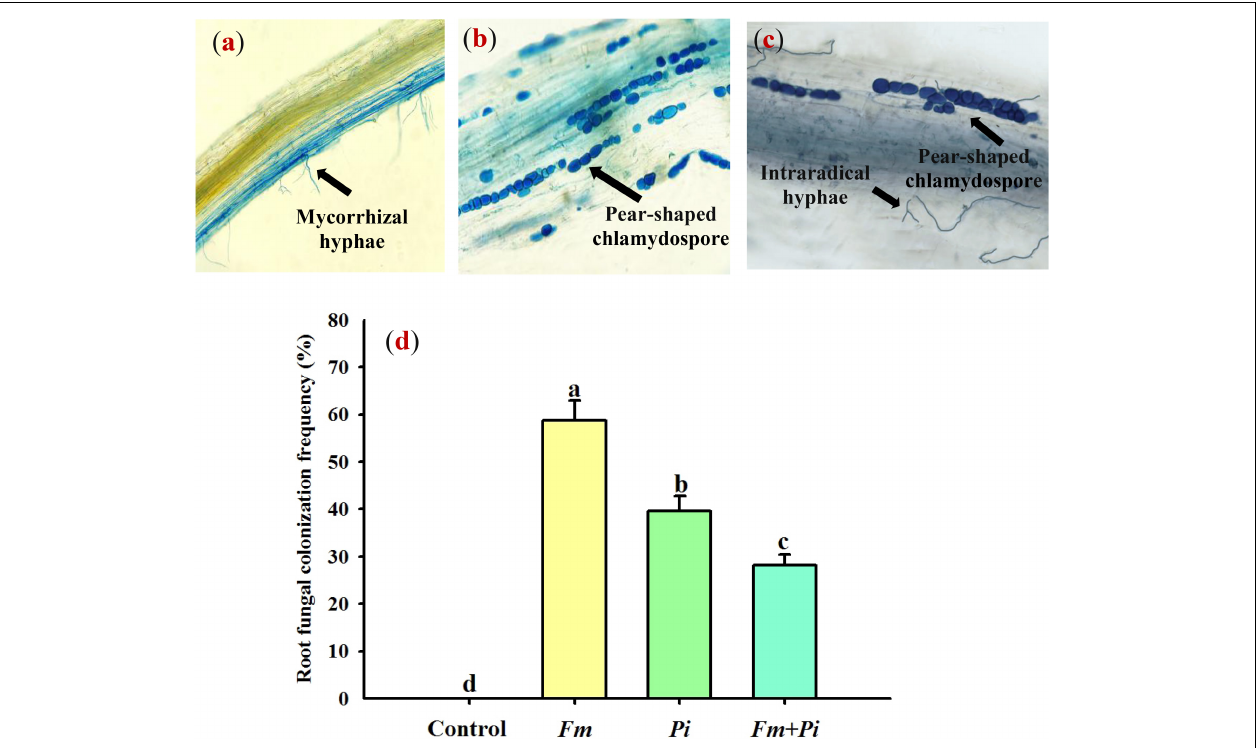
FIGURE 1 | Root fungal colonization of Polygonum cuspidatum Sieb. et Zucc by Funneliformis mosseae ( Fm ) and Piriformospora indica ( Pi ) single or in combination. (a) Fm -inoculated roots; (b) Pi -inoculated roots; (c) roots inoculated with Fm and Pi in combination ( Fm + Pi ); (d) changes in root fungal colonization frequency.